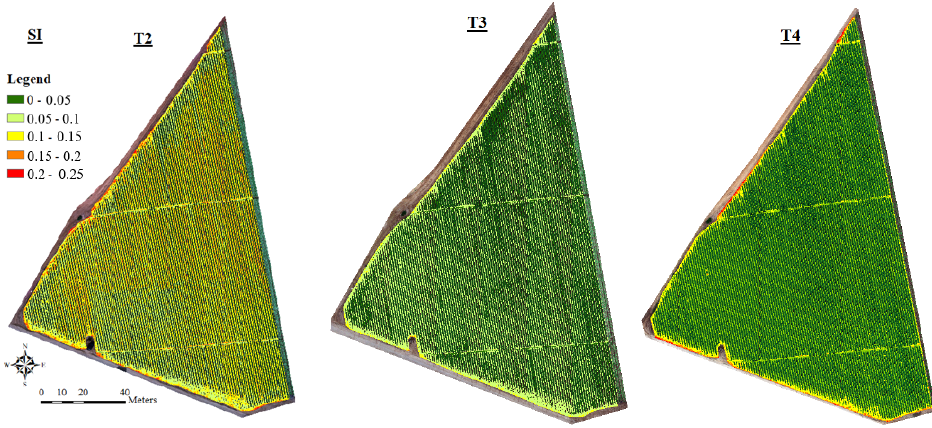
Figure 10. Map of the SI applied to bare soil for T2, T3, and T4.